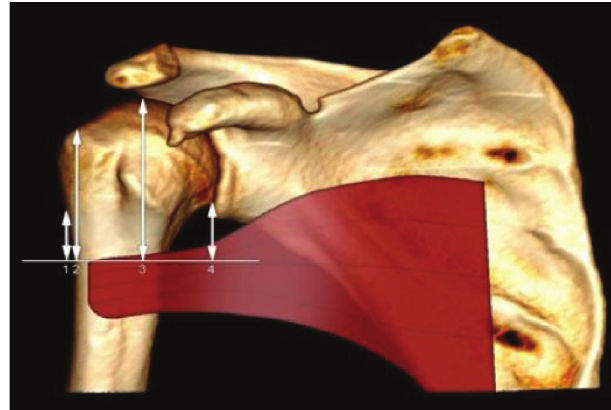
Figure 6. Mean values ± SDs for higher angle and lower angle.